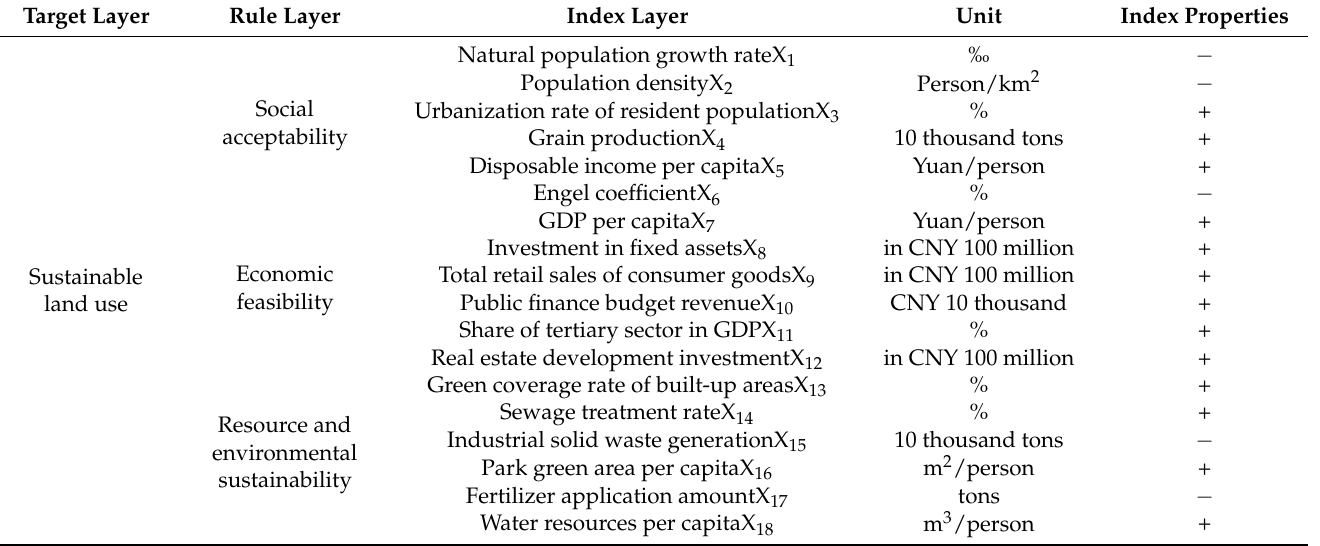
Table 1. Comprehensive evaluation index system for sustainable land use (SLU) in central cities of the Yellow River Basin,